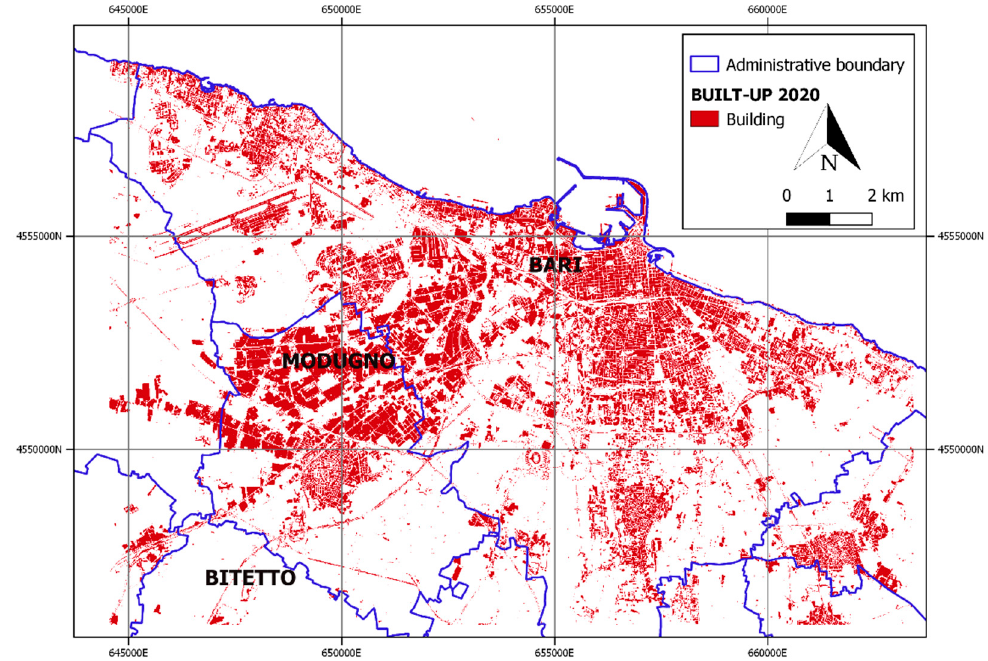
Figure 10. Settlement map of Bari up to date to 2020 from SVM data-driven pixel-based approach.